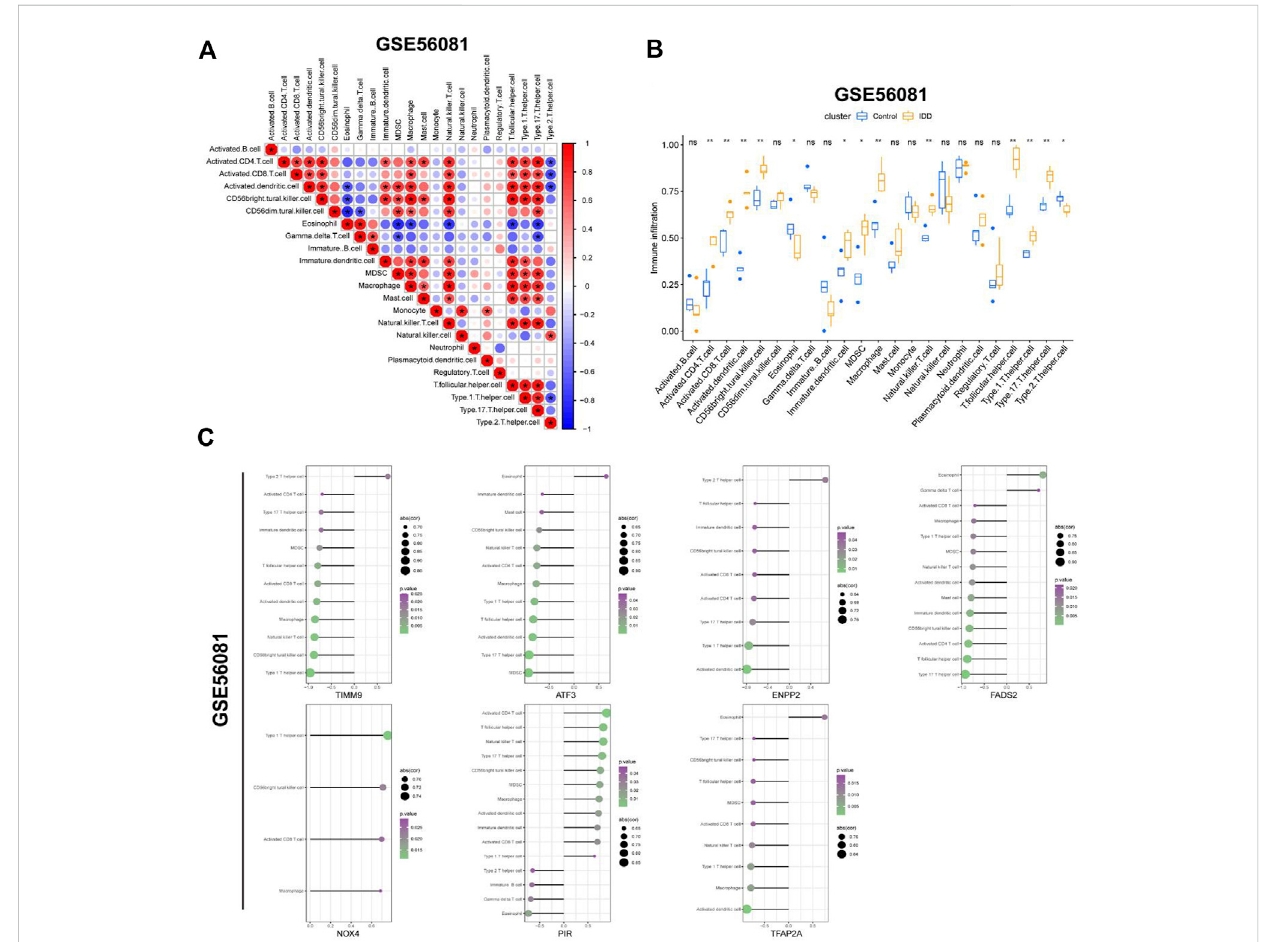
FIGURE 7 Evaluation of immune cell in fi ltration. (A) Correlation between immune cells in GSE56081 dataset. (B) Histogram showed the differences of in fi ltratingimmunecellsbetweenIDDsamples andcontrolsamples(*, p < 0.05; **, p < 0.01). (C) Correlation between theexpression ofkeyDEGs andthe in fi ltration of immune